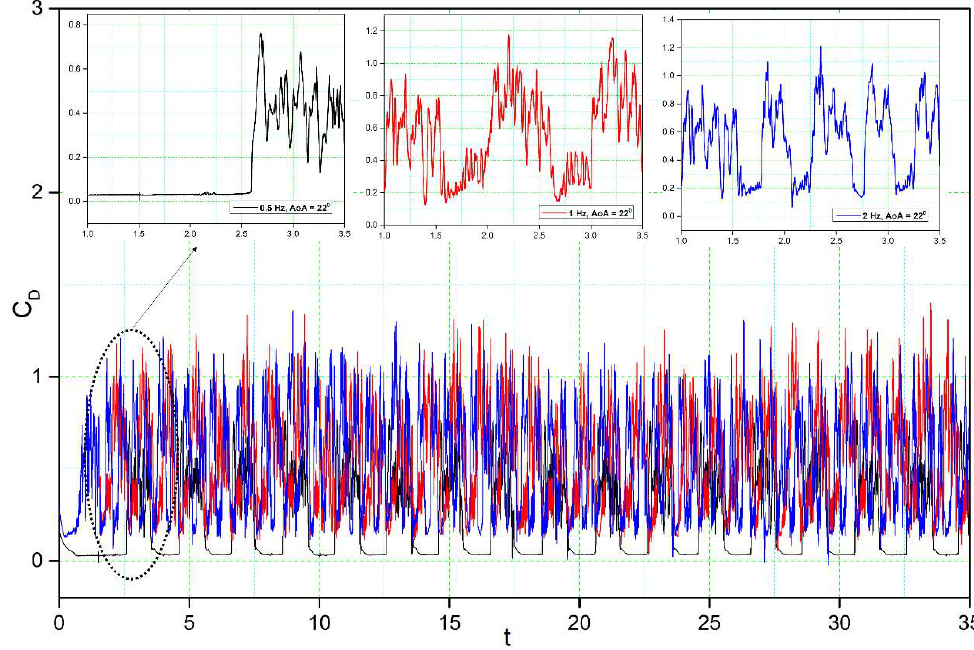
Figure 17. Drag coefficient transient responses for DMLE airfoil at 0.5 Hz, 1 Hz, and 2